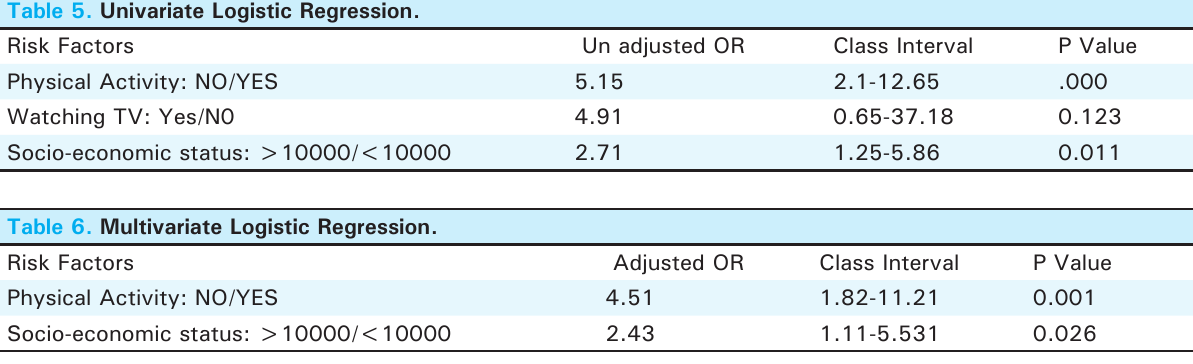
Table 5. Univariate Logistic Regression.